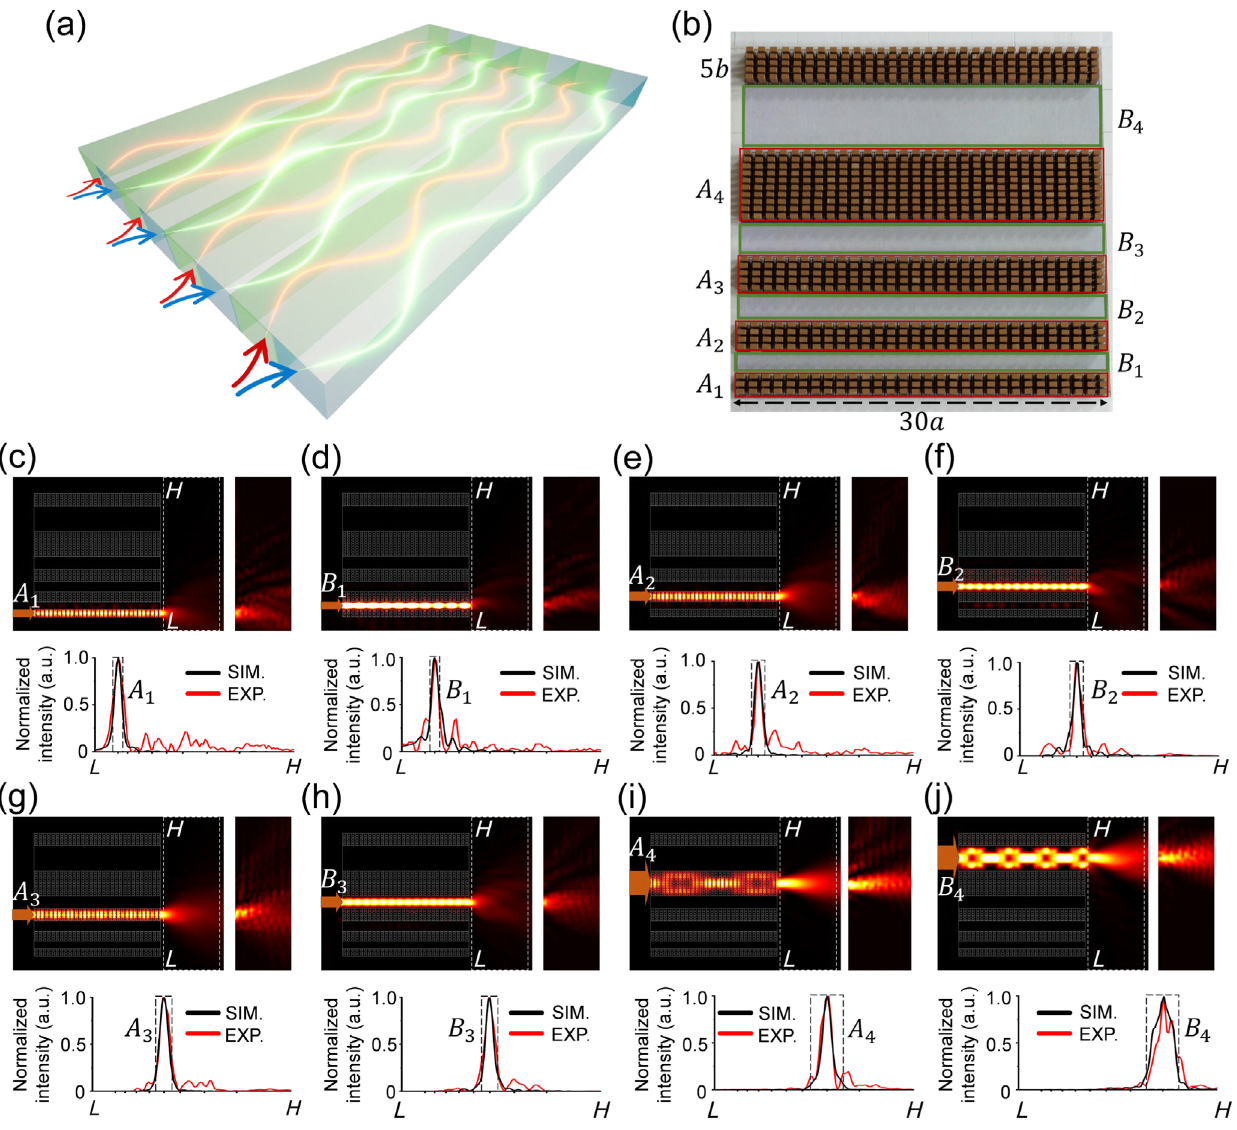
FIG. 4. Numerical and experimental demonstrations for ZSWAs. (a) Schematic graph of a ZSWA constructed by arranging PC and free-space channels alternately. (b) Photo of the experimental sample of the ZSWA. (c) – (j) The simulated (upper panel, left) and measured (upper panel, right) intensity patterns under the independent excitation of the eight channels ð A 1 − 4 ; B 1 − 4 Þ . The white dashed frame marks the experimentally measured region. The lower panels show the normalized intensity distributions on the left edge of the measured